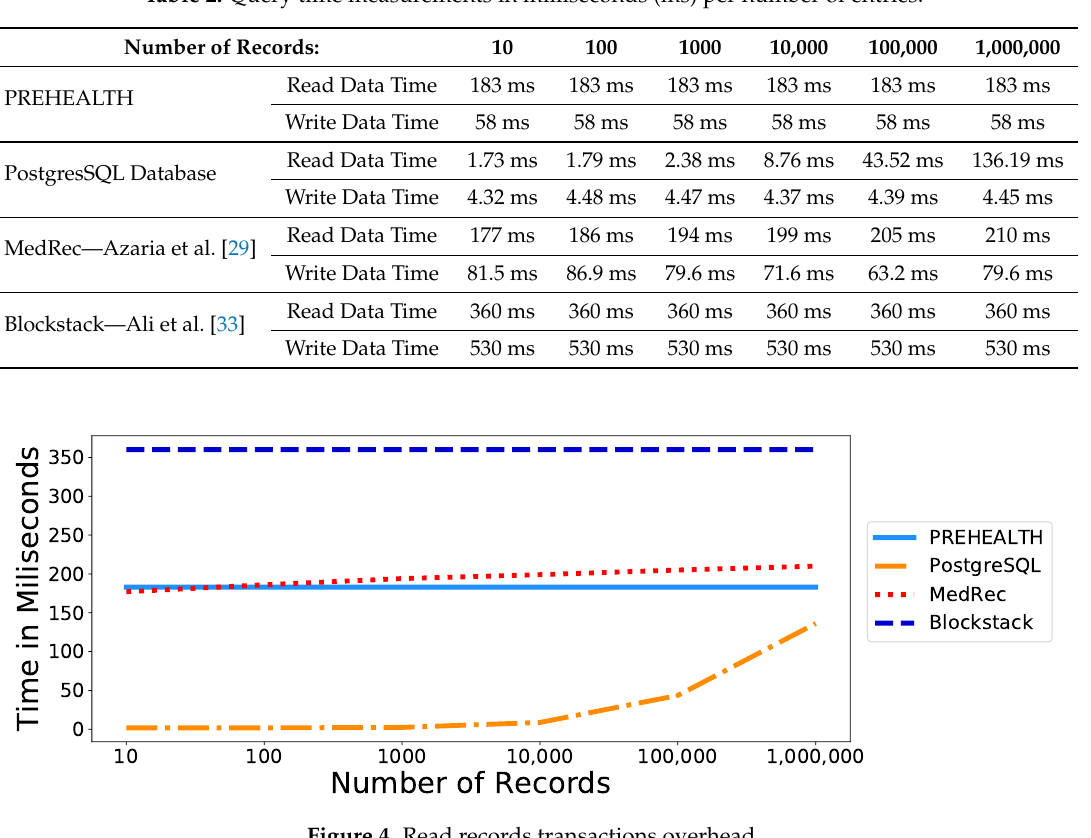
Table 2. Query time measurements in milliseconds (ms) per number of entries.